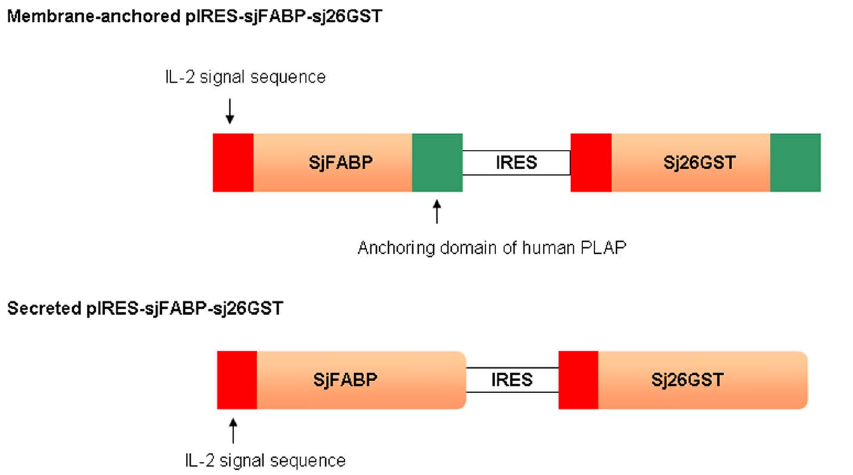
Figure 1. Schematic representation of secreted pIRES-sjFABP-sj26GST and membrane-anchored pIRES-sjFABP-sj26GST gene construction. SjFABP and Sj26GST were chosen as the antigens and pVAC was used as the vector. SjFABP and Sj26GST were modified by addition of 2 coding sequences: A 23-amino acid signal peptide from human IL-2 was added upstream and a membrane-anchored sequence containing 32 amino acids of the carboxyl terminal of human placental alkaline phosphatase (PLAP) was added downstream. The 2 modified genes were then subcloned into a pIRES eukaryotic expression vector, which is a new-generation multigenic vector with 2 open reading frames that enables each product of transcription to be translated independently. The antigens expressed in the recombinant vaccine were then anchored to the cell membrane. The absence of the membrane-anchored sequence downstream led to the synthesis of a secretory antigen.